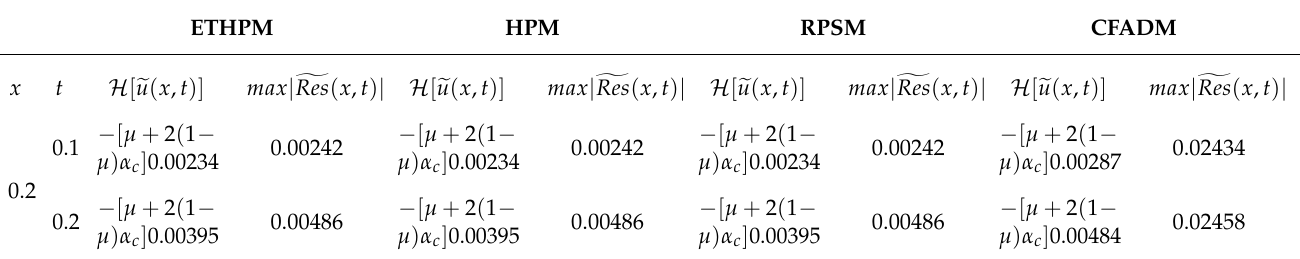
Table 5. H [ (cid:101) u ( x , t )] and max | (cid:103) Res ( x , t ) | by ETHPM, HPM, RPSM, CFADM for α =